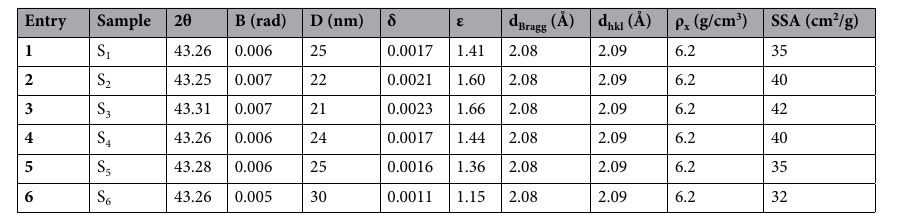
Table 2. Crystallite size (D), dislocation density (δ), strain data (ε), interplanar spacing (d) and X-ray density (ρ x ) of the as-synthesized